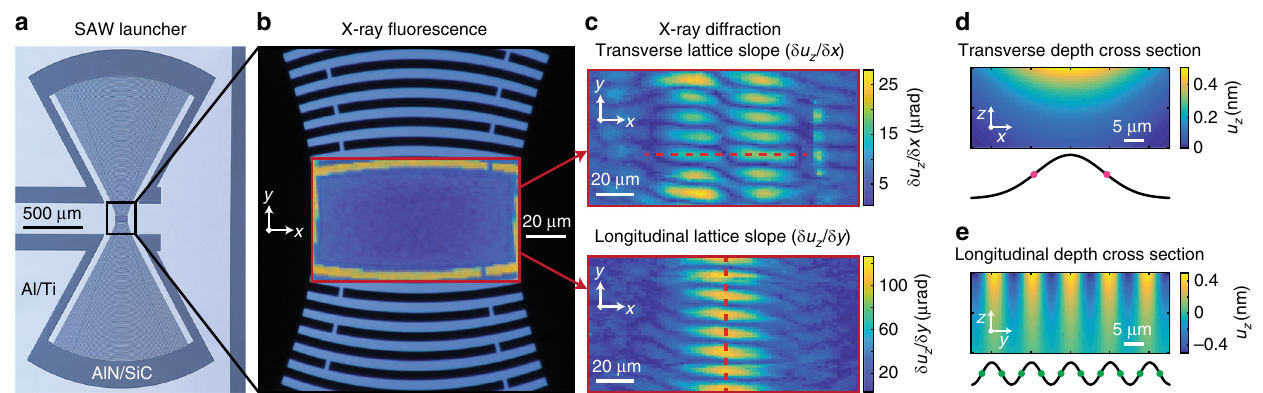
Fig. 2 Stroboscopic Scanning X-ray Diffraction Microscopy (s-SXDM) measurements made on a Gaussian SAW. a With the wave propagation direction aligned orthogonal to the x – z scattering plane. b The scanning X-ray Bragg diffraction measurements are registered relative to the patterned IDT using fl uorescence from the Ti adhesion layer of the Al electrodes. The device background image is a dark fi eld optical micrograph. c The far- fi eld X-ray diffraction pattern is sensitive to the local curvature (tilt) of the lattice planes calculated as the gradient of the displacement in two ordinal components. The oscillatory transverse and longitudinal shifts of the X-ray diffraction pattern oscillation are independently detected as peak-to-peak displacements in the centroid position spot relative to the X-ray scattering plane. d , e The expected depth dependence of an ideal Gaussian surface acoustic wave displacement ( u z ) along the transverse x ( d ) and longitudinal y ( e ) directions at the dashed red lines in c . The transverse (longitudinal) curvature maxima, signi fi ed with magenta (green) dots, correlate with the double (single) lobed periodic features, respectively, experimentally observed in c . The calculated displacements correspond to the experimentally observed curvature amplitude